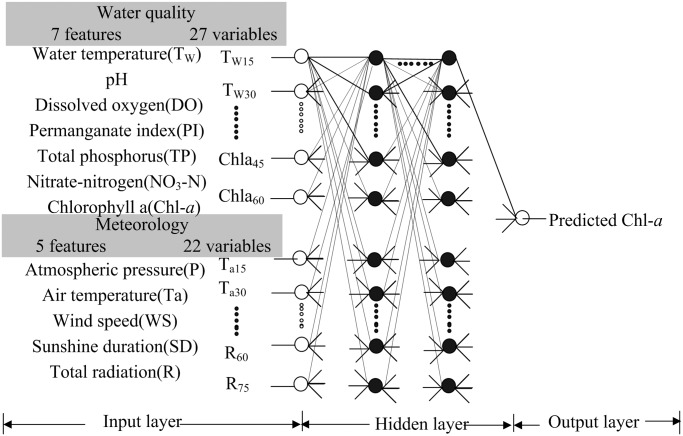
Configuration of the Chlorophyll-a (Chl-a) predictor using artificial neural networks (ANN).Left: input water quality and meteorological variables extracted by the correlation coefficient threshold method; middle: configuration of the predictor; right: predicted Chl-a. White circles on the left and right represent input and output neurons, respectively. Black circles represent neurons in the hidden layer. Lines around the circles indicate the data flow. A total of 49 variables of 12 features (27 variables of 7 water quality features and 22 variables of 5 meteorological features) were used.